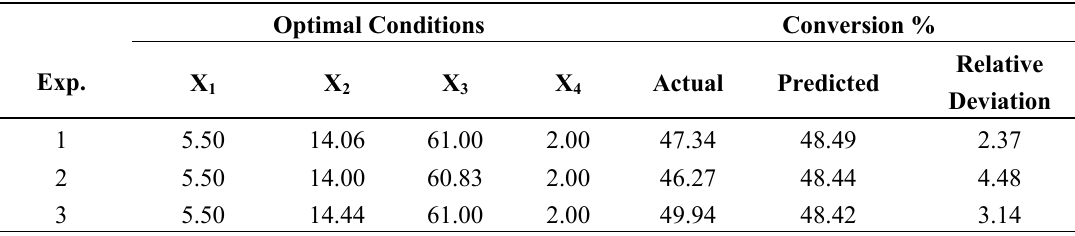
Table 5. Optimum conditions derived by Taguchi design for TEA-based esterquat cationic surfactant synthesis.